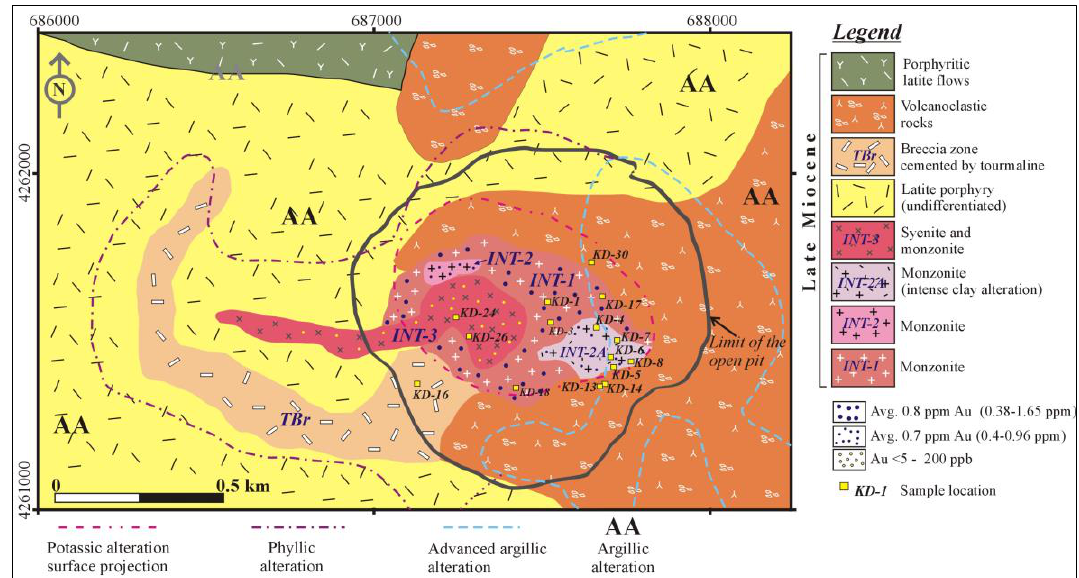
Figure 3. Lithological map of the Kışladağ Au deposit (modified after [17]; Au grades from [14]).